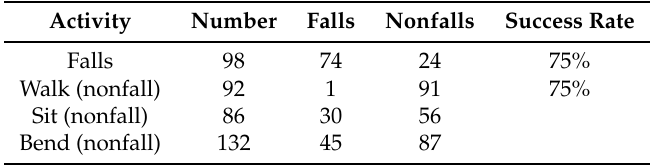
Table 1. Experimental results show the proposed CNN classifier achieves a high fall detection